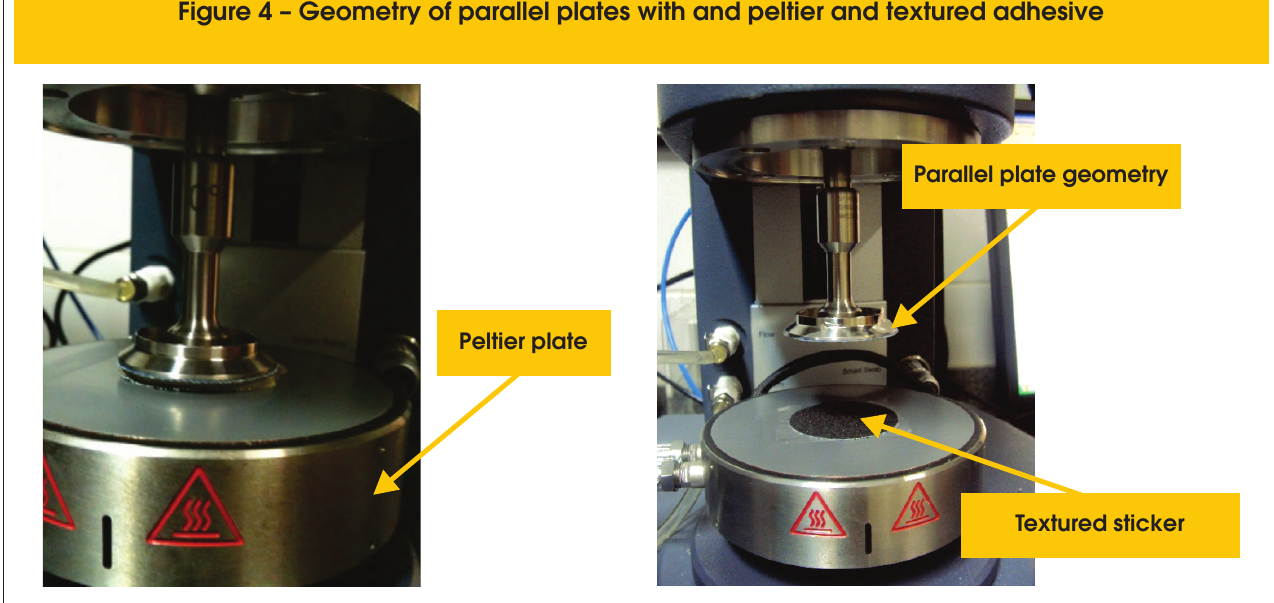
Figure 4 – Geometry of parallel plates with and peltier and textured